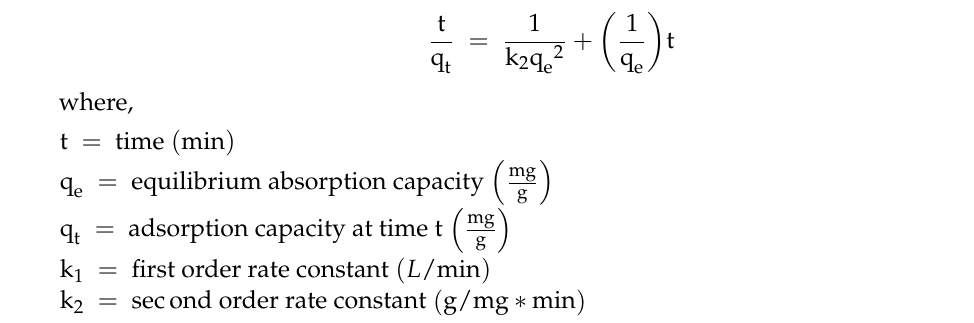
Table 5. Kinetic parameters for dark adsorption of methylene blue onto nanocomposites. Pseudo-First-Order Model Pseudo-Second-Order